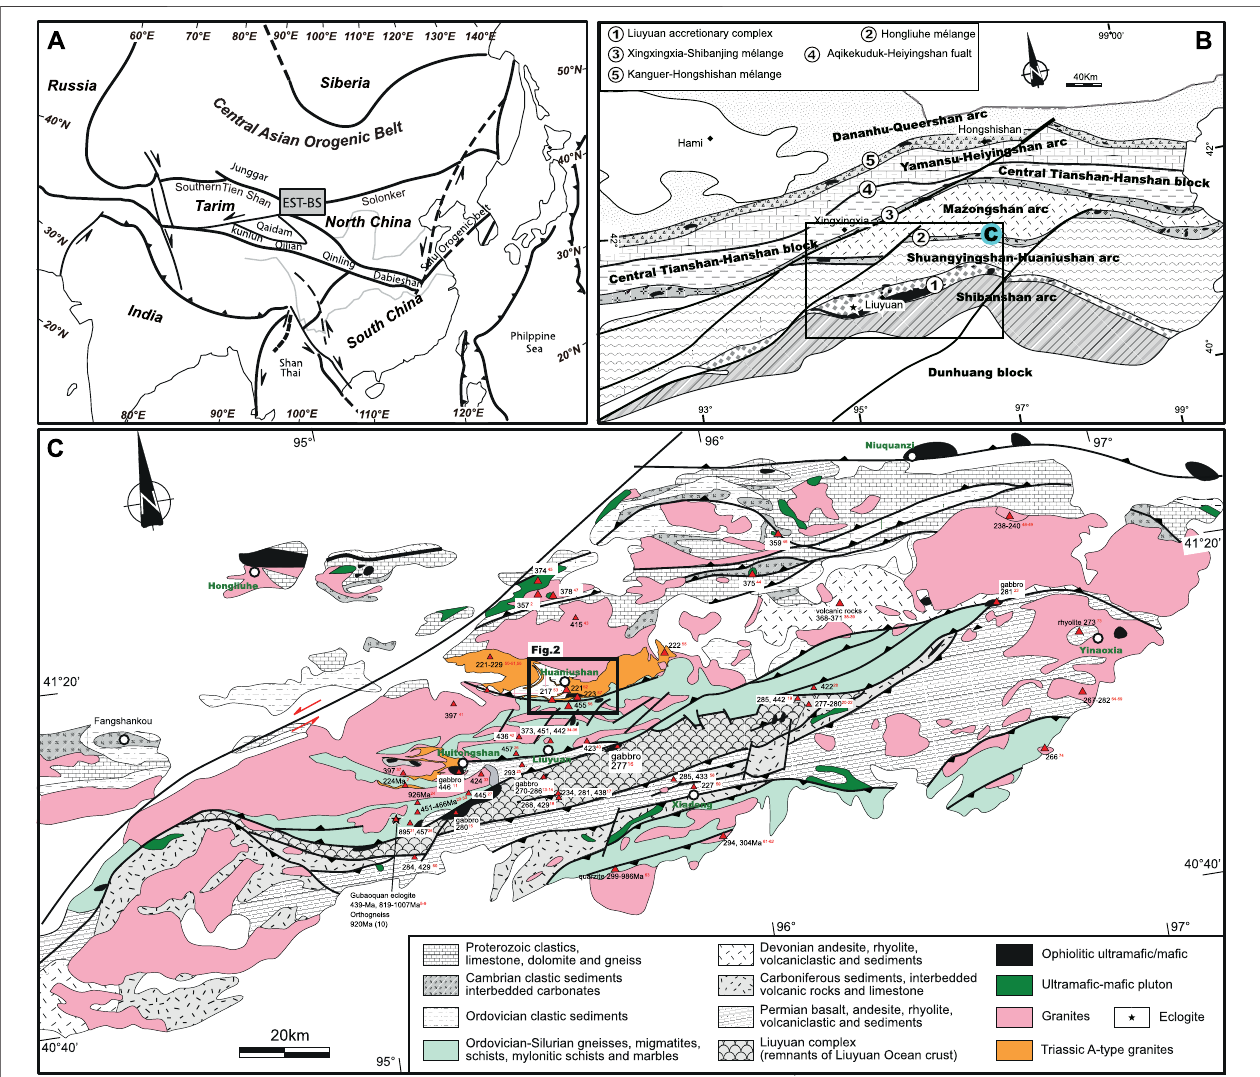
FIGURE1 |(A) Schematic tectonic map ofCentral Asia and adjacentregions, showing thetectonic position ofthe Beishan orogen ( Ş engör et al., 1993; Xiaoet al., 2018)EST-BS,easternTianshan-Beishanorogen. (B) TectonicmapoftheBeishanorogenicbelt,showingthepositionoftheLiuyuanaccretionarycomplexinrelationto thethreemainarcs(Xiaoetal.,2010). (C) GeologicalmapoftheLiuyuanaccretionarycomplexandadjacentareasshowingtherelationswiththemainstratigraphicunits of the Beishan (GSBGMR, 1989; Mao et al., 2012b).